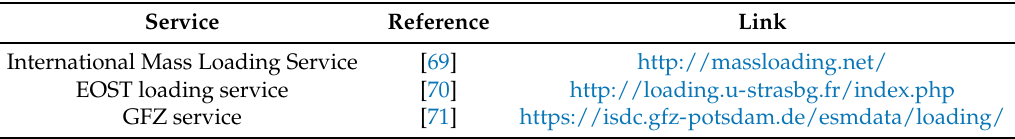
Table 3. Environmental loading